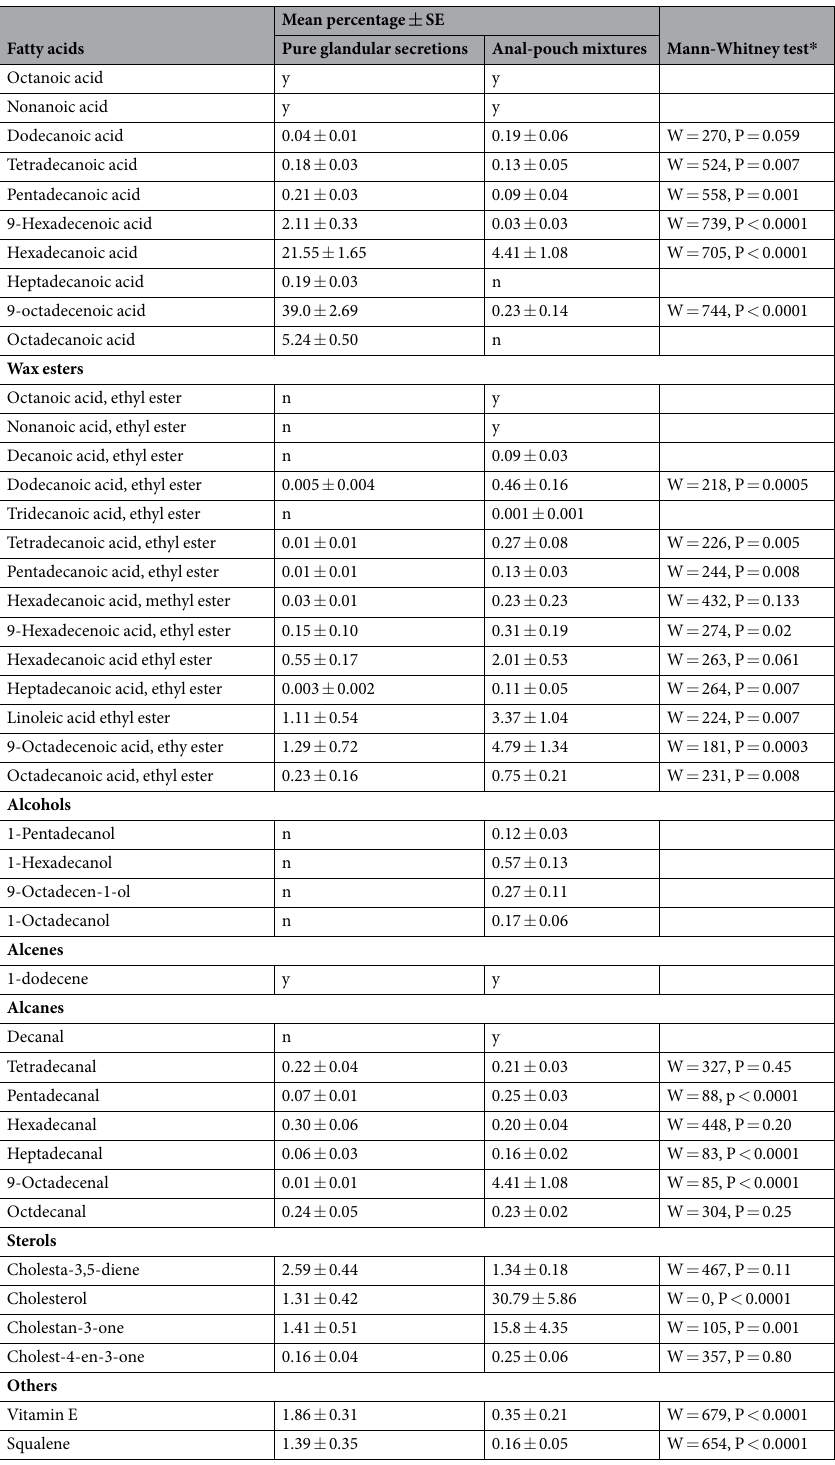
Table 1. Mean percentage ± SE of the chemical compounds putatively identified in the pure and mixed anal gland secretions of subordinate meerkats. * P values are not corrected for multiple testing 73 . Differences in abundance between pure and mixed secretions were tested using Mann-Whitney tests. Y: denotes a compound that was detected, but that was not included in the comparison between pure and mixed secretions (these compounds, being at the edge of the chromatograms, were only detected in the pure secretion samples run on the GCMS column used to analyse mixed secretion samples). n: denotes a compound that was not detected in a given type of sample. All compounds listed above had an assignment probability >